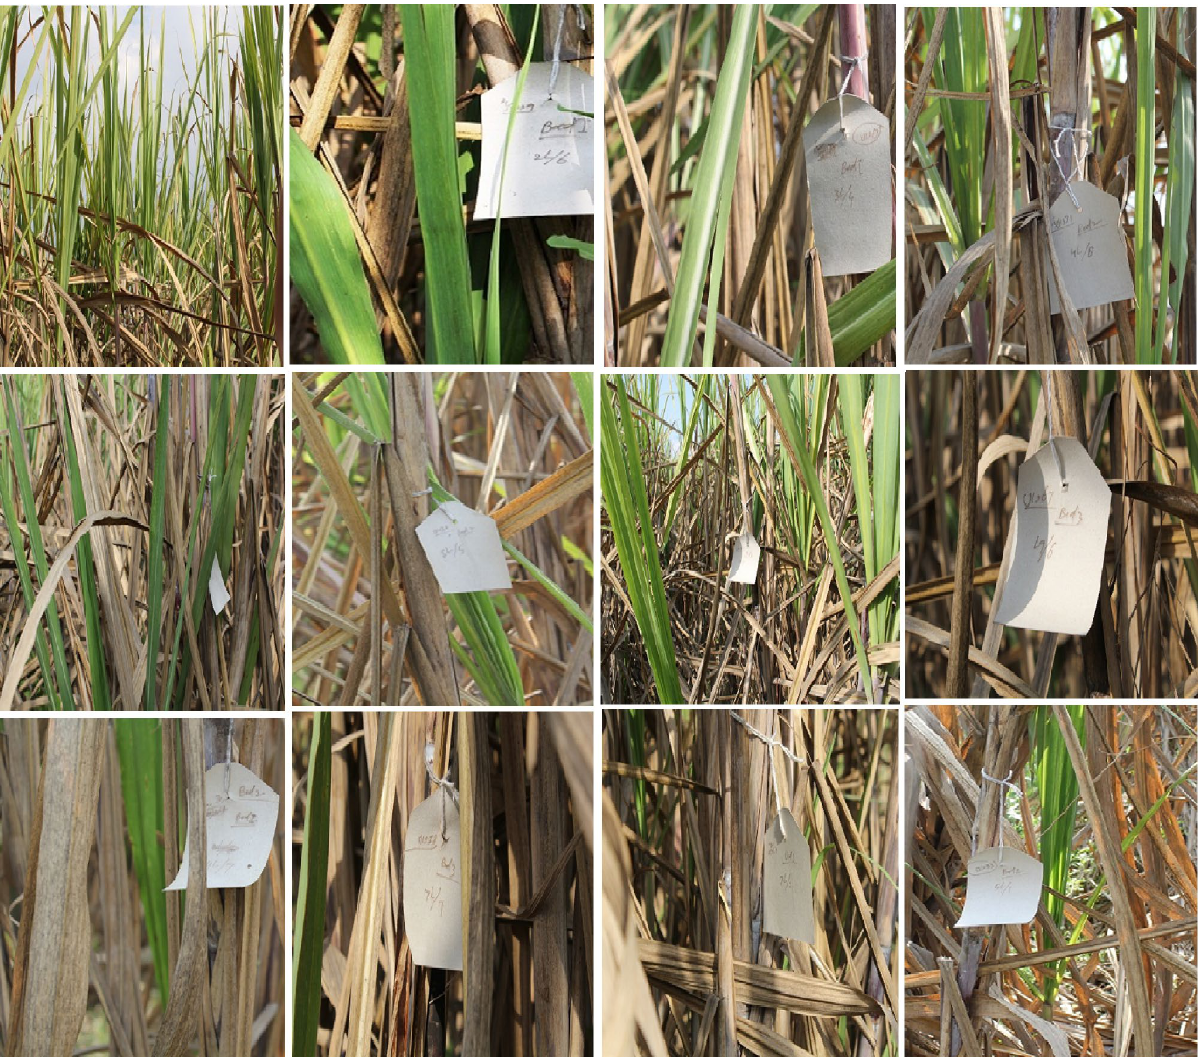
Figure 13. Glyphosate tolerant and cane borer resistant lines of V 1 -generation during the field